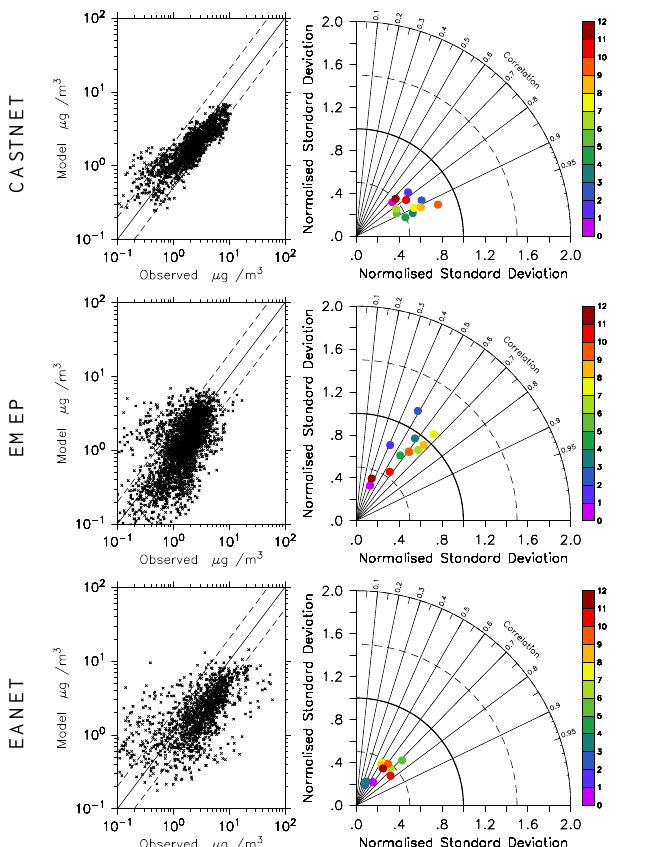
Fig. 8. As Fig. 6 but for NO − 3 . 4